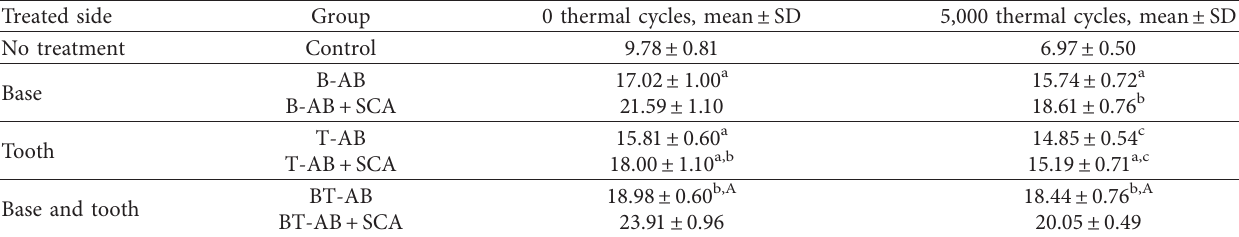
Groups with similar letters are not significantly different from each other. Vertically identical superscripted small letters denote no significant differences among groups ( P > 0 . 05 ) . Horizontally identical superscripted capital letters denote no significant difference after thermal cycling within the surface treatment group ( P > 0 . 05 ) .